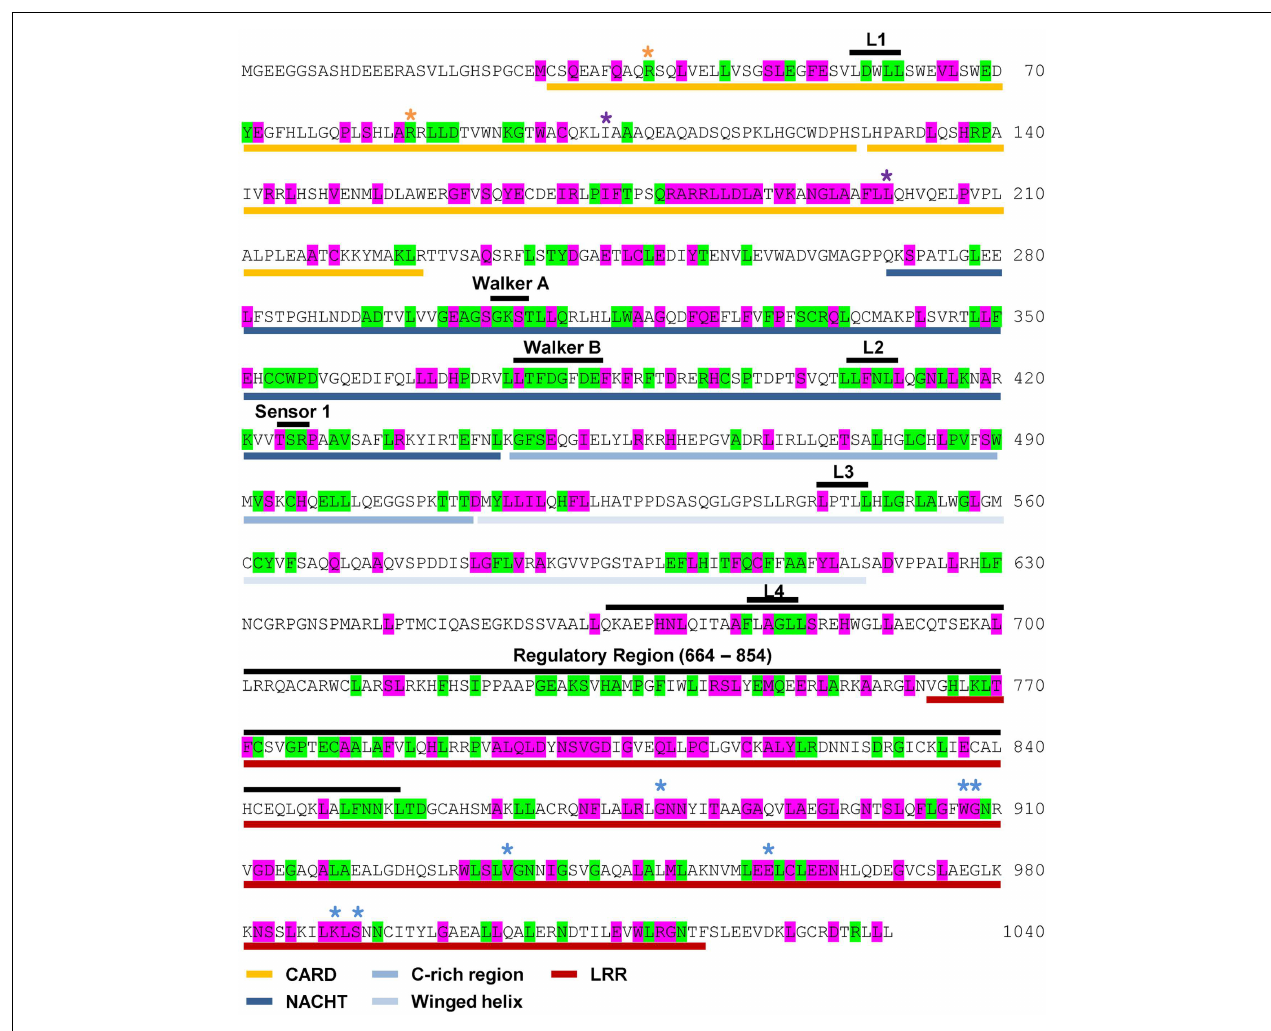
binding, theWalker A and B motifs, the Sensor 1 region and the regulatory region from residues 664 to 854 are all labeled in black above the relevant sequence. Also labeled above the sequence are the LxxLL motifs [black bars (L1, L2, L3, L4)], residues predicted to be important for interaction with RIP2 (yellow asterisks), ubiquitin binding (purple asterisks), and residues predicted to be involved in ligand recognition (blue asterisks).